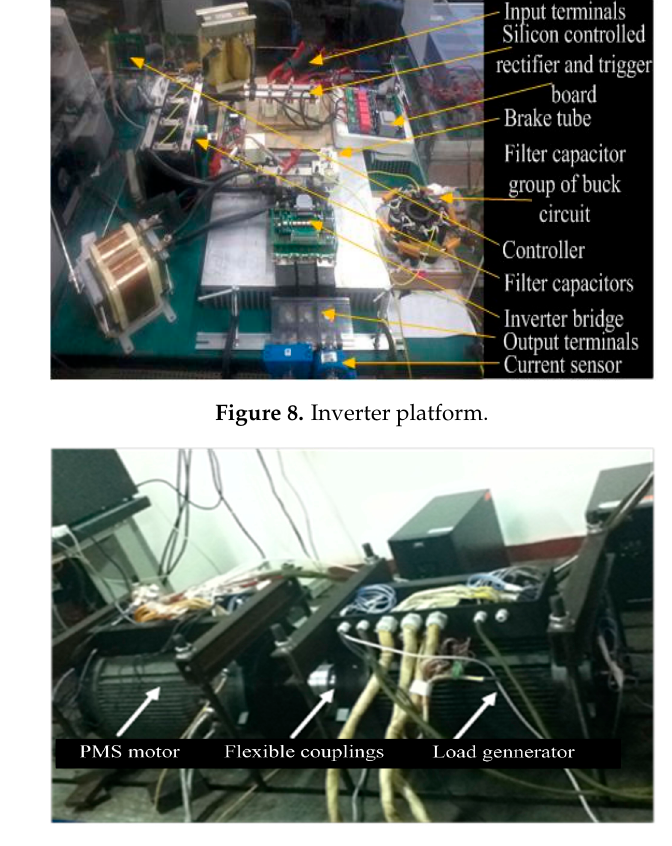
Figure 9. Experiment platform for start-up and operation with load.